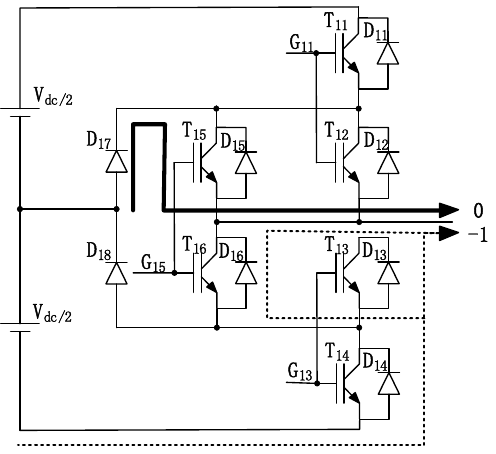
Figure 10. ID4 type ( α = − 1, M ≈ 0).